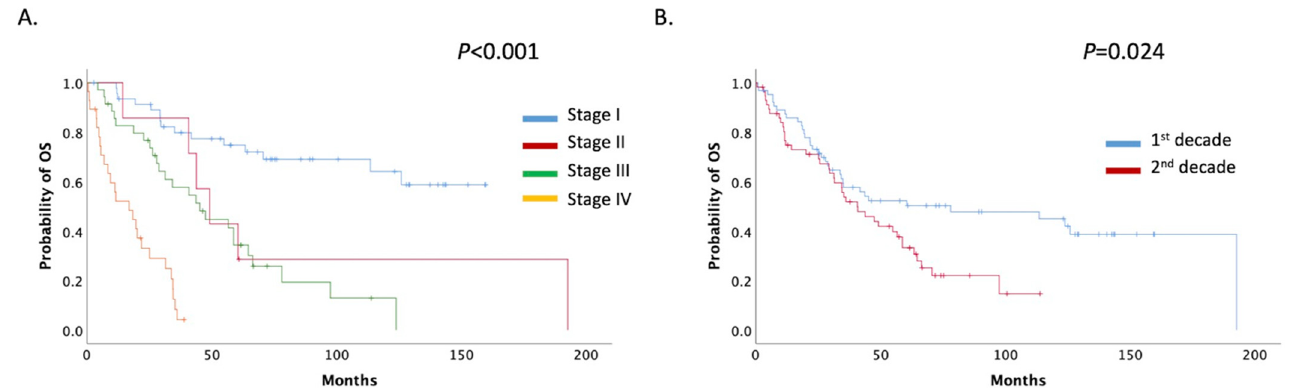
Figure 4. ( A ) Patients mOS stratified by stage; ( B ) Patients mOS stratified by decade (1st decade: 1999–2009, 2nd decade: 2009–2019).